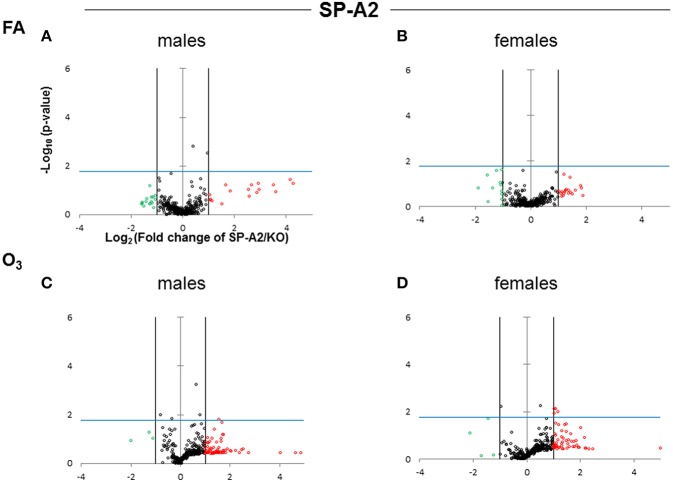
Volcano plots (as described in Figure 2) indicating the statistical significance of SP-A2 T2C miRNome expression levels compared to SP-A KO under FA or O3 exposure for males and females. (A) Male SP-A2 mice compared to KO exposed to FA; (B) Female SP-A2 mice compared to KO after FA exposure; (C) Male SP-A2 mice compared to KO after O3 exposure; (D) Female SP-A2 mice compared to KO after O3 exposure.